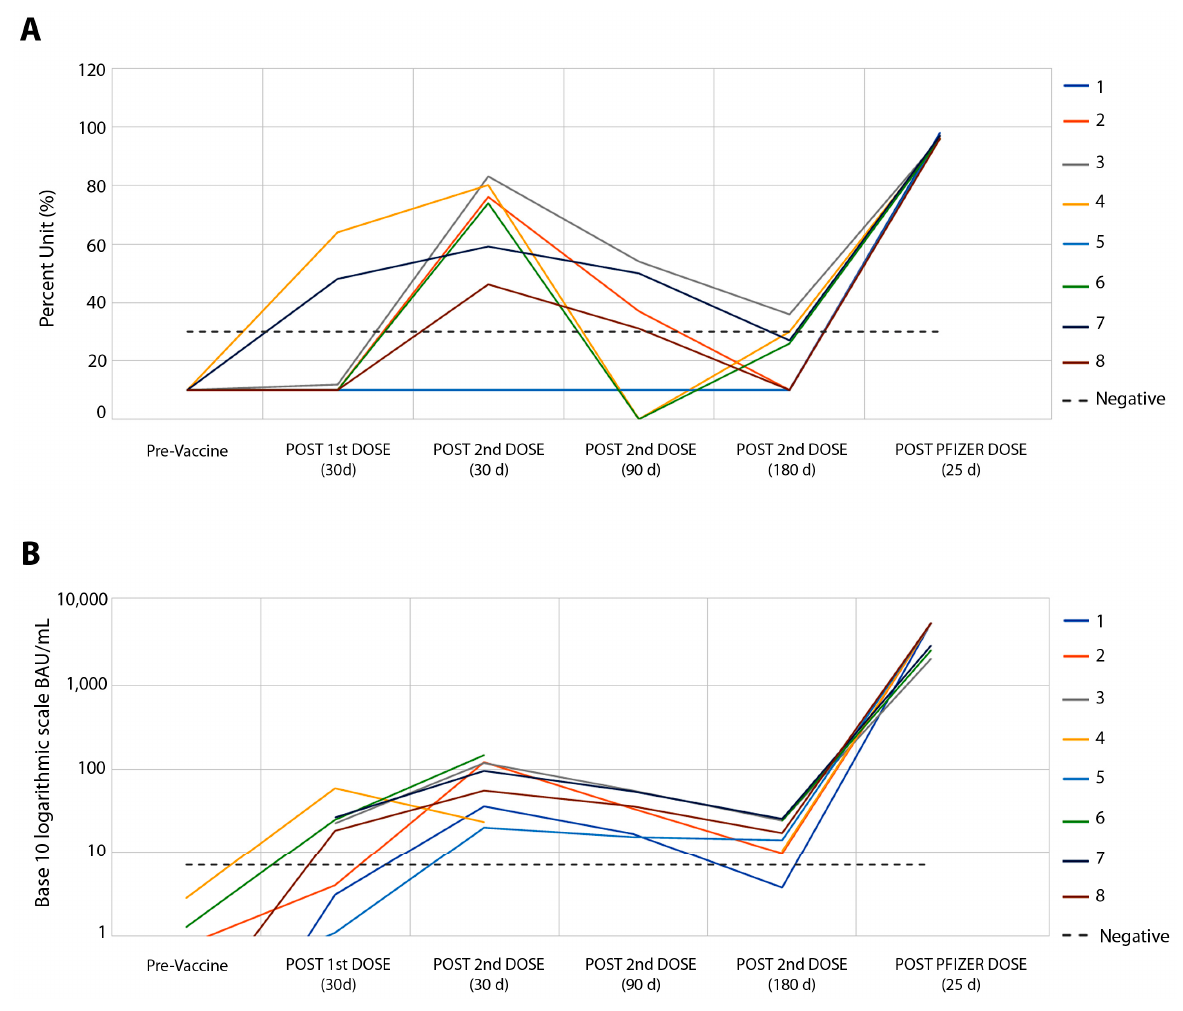
Figure 1. Follow-up of eight volunteers from pre-CoronaVac vaccine to Pfizer booster. ( A ) SARS- CoV-2 Surrogate Virus % Neutralization Test, sVNT (cPass™ GenScript USA, Inc., Piscataway NJ, USA). There was no difference between the results of neutralizing antibody tests between the sVNT and CPE-VNT methods, p > 0.131. ( B ) Automated chemiluminescent assay (CMIA) SARS-CoV-2 IgG II Quant, performed on the ARCHITECT i System (Abbo tt Ireland Diagnostics Division).